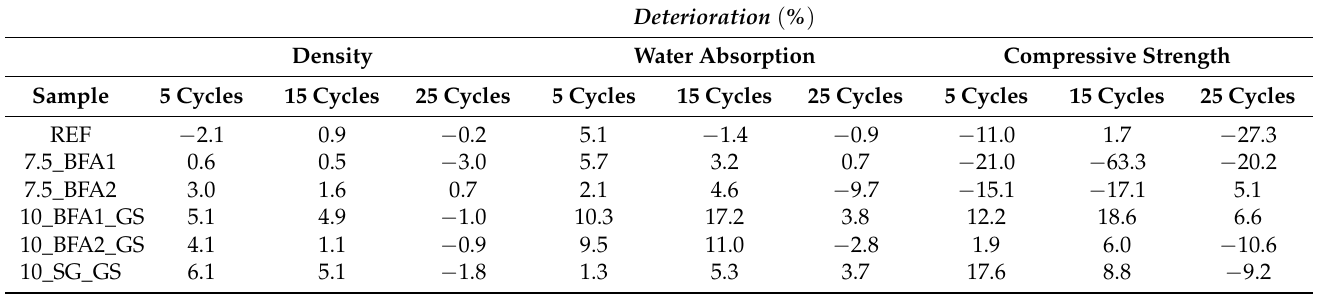
Table 4. Properties Deterioration ( % ) of samples subjected to 5, 15, and 25 consecutive freeze- thaw cycles.